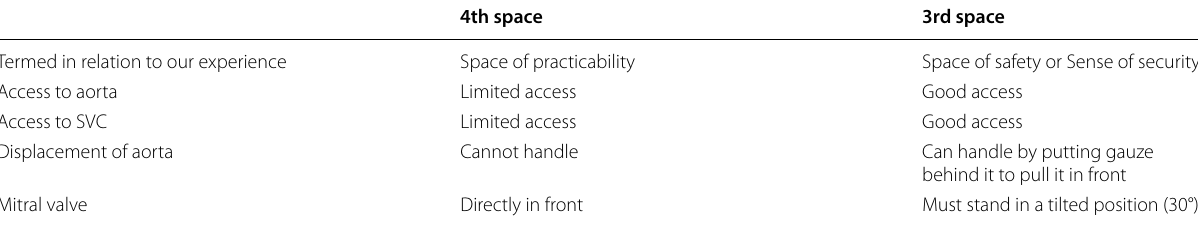
Table 5 Pros and cons of 3rd and 4th space according to our surgical